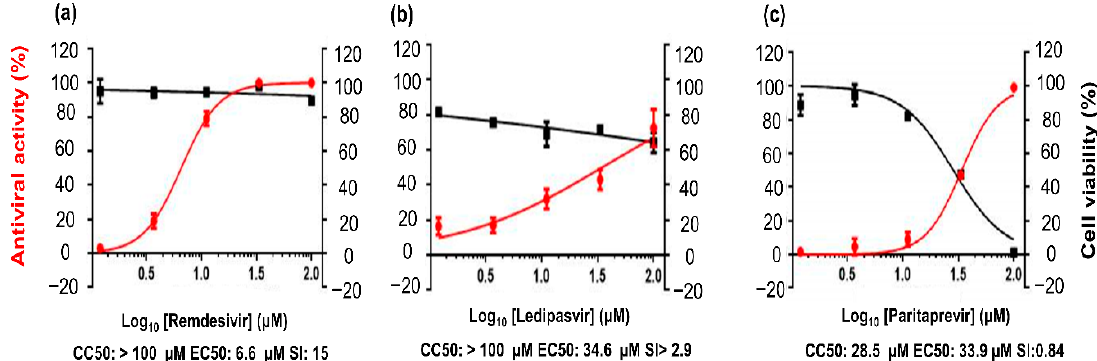
Figure 8. In vitro evaluation of antiviral activity of the drug candidates against SARS-CoV-2. ( a – c ) The right vertical axis represents cell viability, and the left vertical axis denotes antiviral activity against SARS-CoV-2.